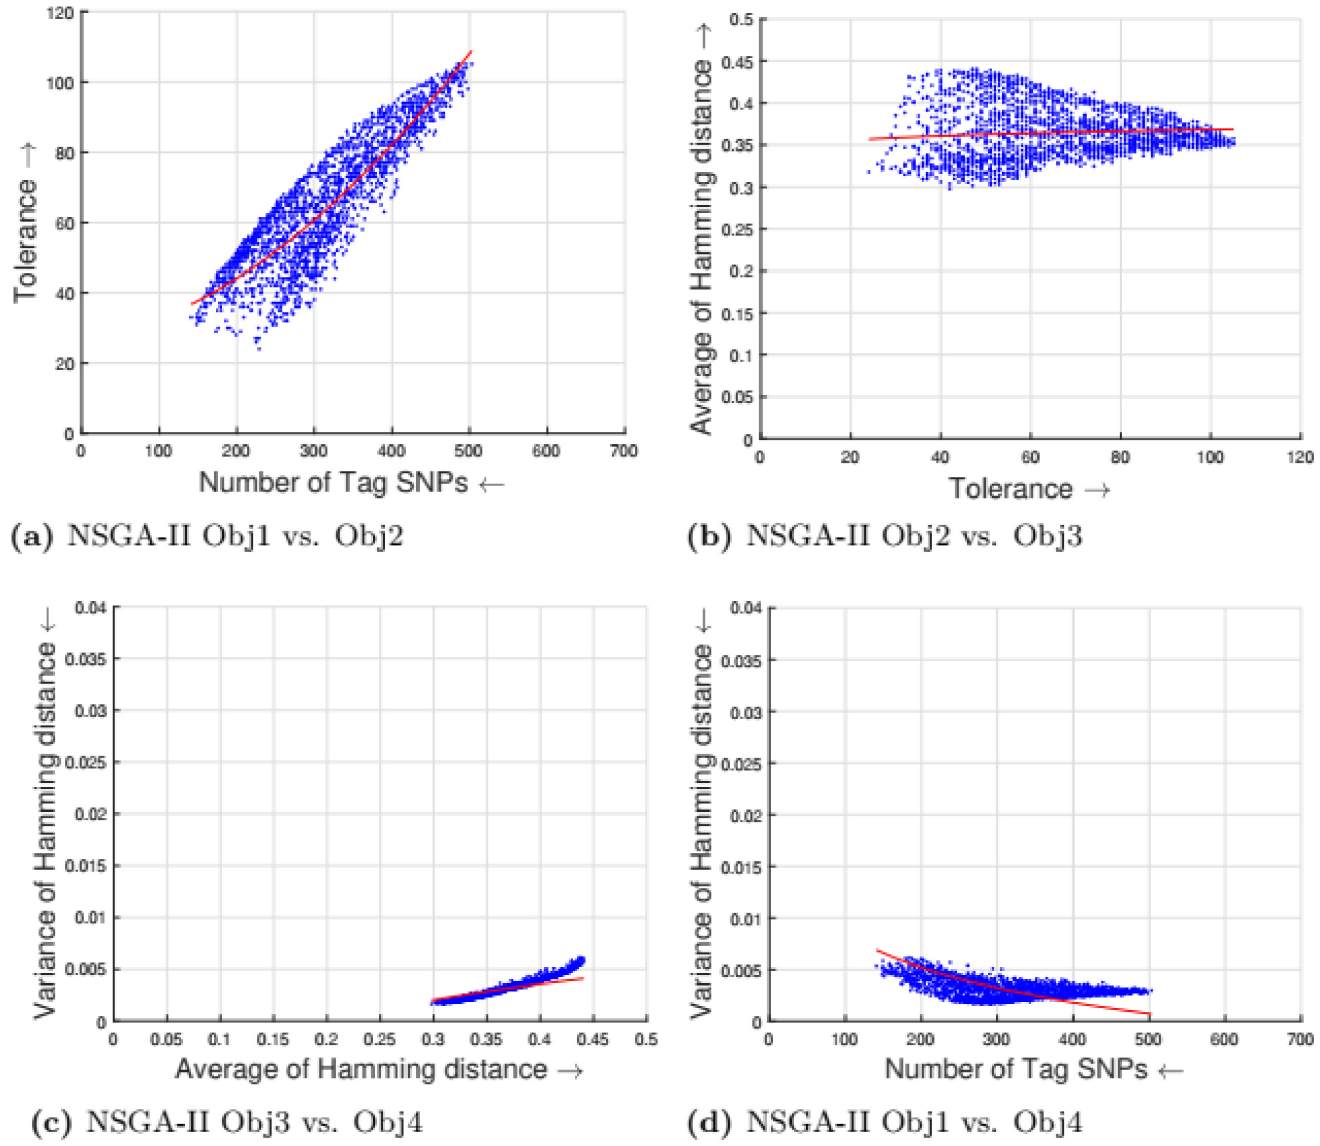
Fig 5. Experimental results of NSGA-II using greedy initialization for the tag SNPs selection problem. Obj1 stands for the number of tag SNPs, Obj2 is the tolerance for missing data, Obj3 measures the average Hamming distance between alleles, and Obj4 controls the variance of detection power in each allele. (a) NSGA-II Obj1 vs. 0bj2, (b) NSGA-II Obj2 vs. 0bj3, (c) NSGA-II Obj3 vs. 0bj4, (d) NSGA-II Obj1 vs. 0bj4.